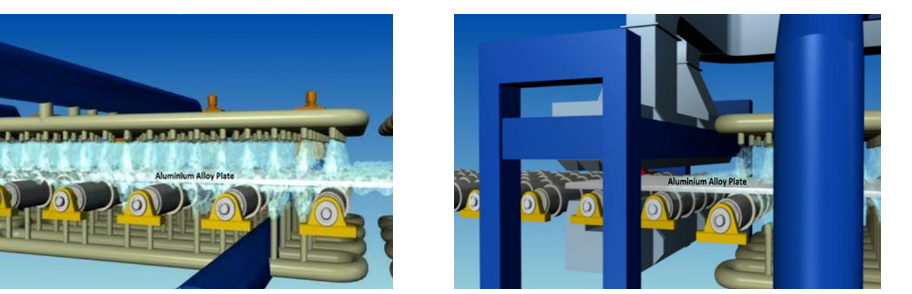
Figure 6. The plate is in the quenching area. Figure 7. The plate comes out of the quenching